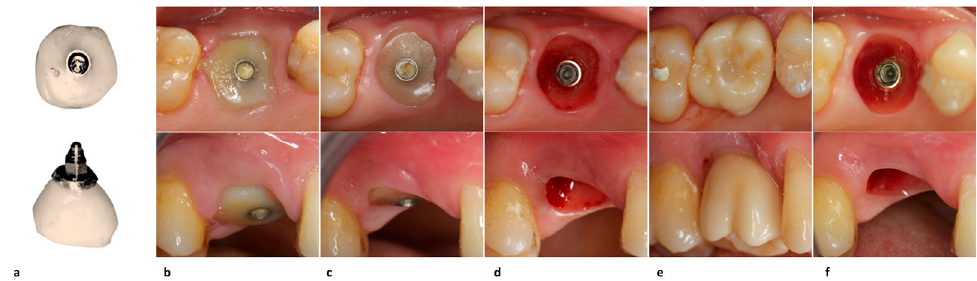
Figure 3. Prosthetic steps with occlusal (upper) and lateral views (lower). Semi-finished peek-core customized healing abutment ( a ); healing of mucosa around the PEEK core abutment covered with composite resin 1 week after surgery ( b ); implant site with ( c ) and without ( d ) the finished customized healing abutment 1 month after surgery; restored implant with ( e ) and without ( f ) single crown fixed prosthesis 3 months after surgery.